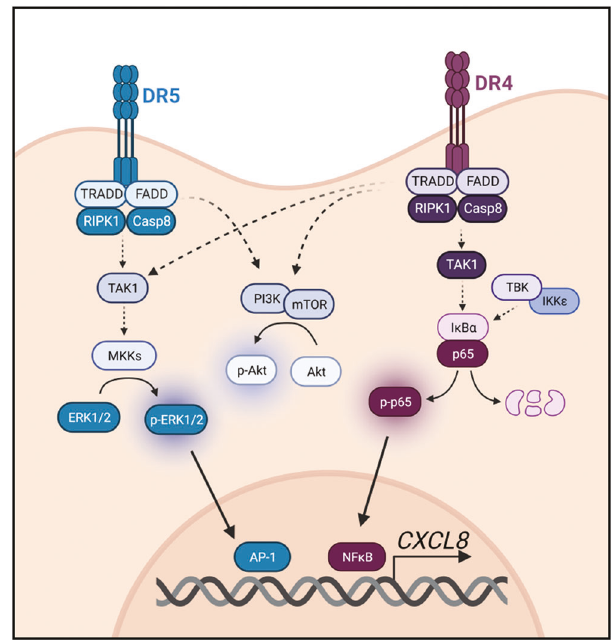
Fig. 8 Diagram of IL-8 regulation via TRAIL death receptors 4 and 5. DR4 and DR5 activate IL-8 production through the MEK MAP kinases and AP-1. Death receptor downstream signaling includes TRADD, FADD, RIPK1 and Caspase-8. DR4 additionally regulates NF-kB. Both receptors regulate the PI3K-AKT pathway but this has no apparent role in IL-8